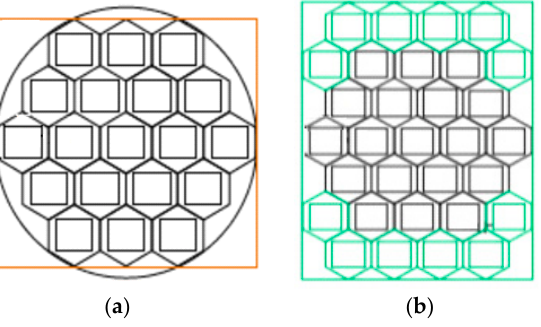
Figure 5. ( a ) Original antenna in PARIS IoD, and ( b ) antenna of GEROS ISS corresponding to the Phase A study led by Airbus Defense and Military.